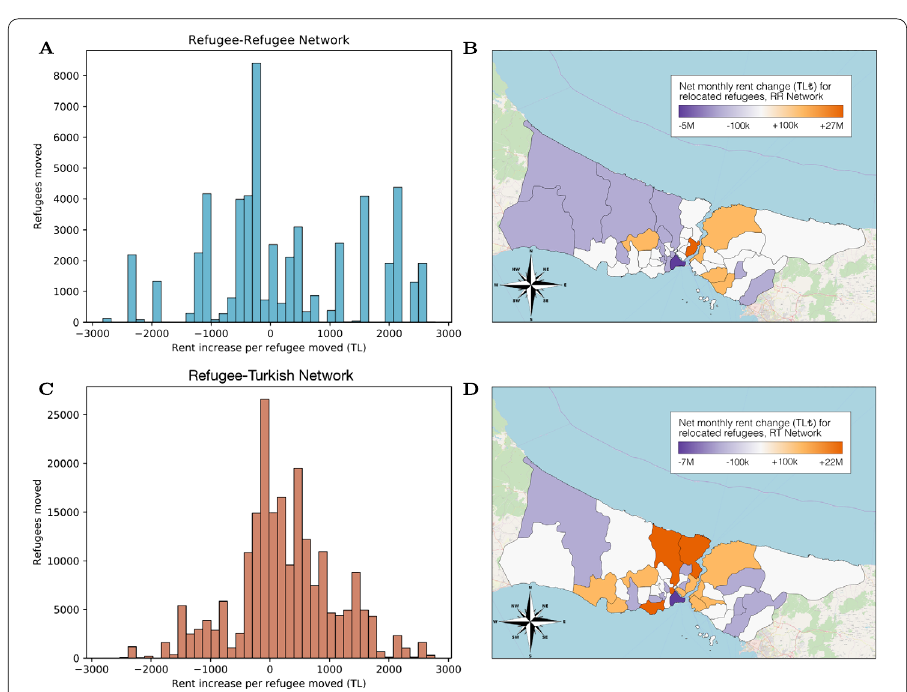
Figure 8 The histograms at left illustrate the distribution of monthly rent changes after optimisation, for the Refugee–Refugee and Refugee–Turkish networks respectively. The height of the vertical bars indicates the number of relocated refugees whose rent payments increased or decreased by the value indicated on the horizontal axis. Subsequently, the maps at right indicate, for each respective network, the total monthly rent change per district. That is, the product, for each origin district j and destination district i , of the difference in rent cost between j and i and the number of refugees moved m to the destination district. Thus, formally, the (cid:2) reported rent change per district i is obtained as v i = ∀ j m ij ( c i – c j )